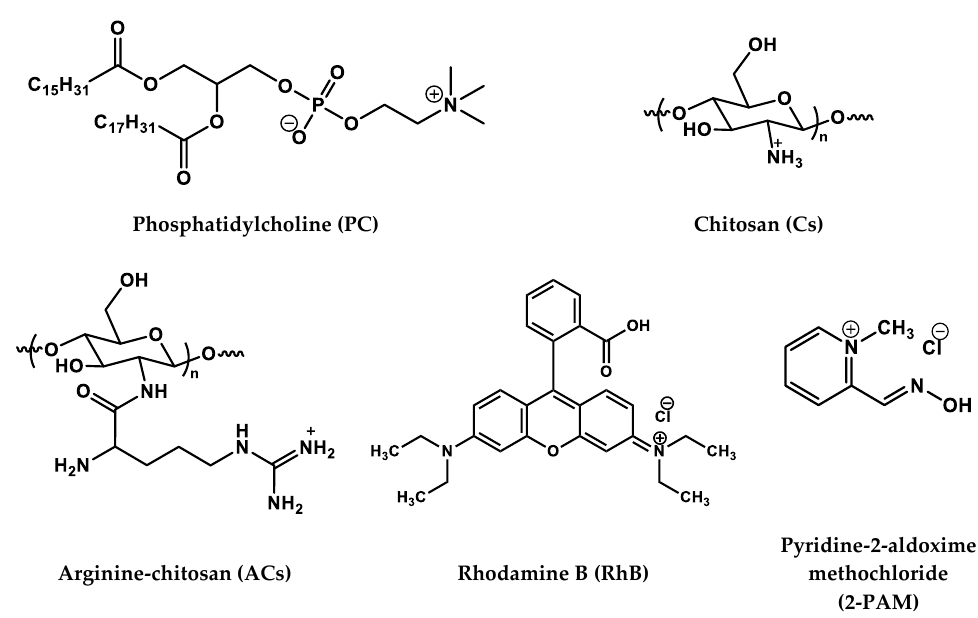
Figure 1. Chemical structure of lipid, polymers, and substrates.